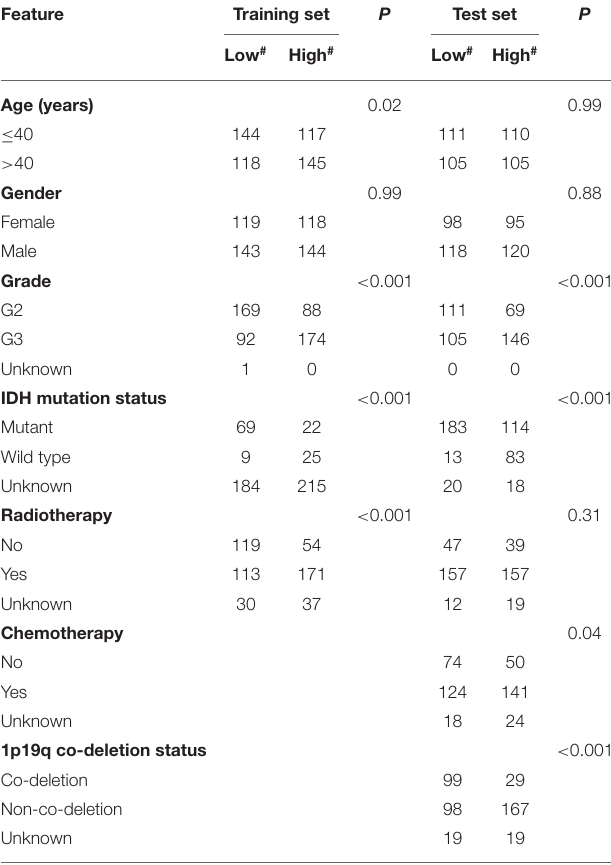
TABLE 1 | Relationship of the five-gene signature with features in the two groups with LGG.